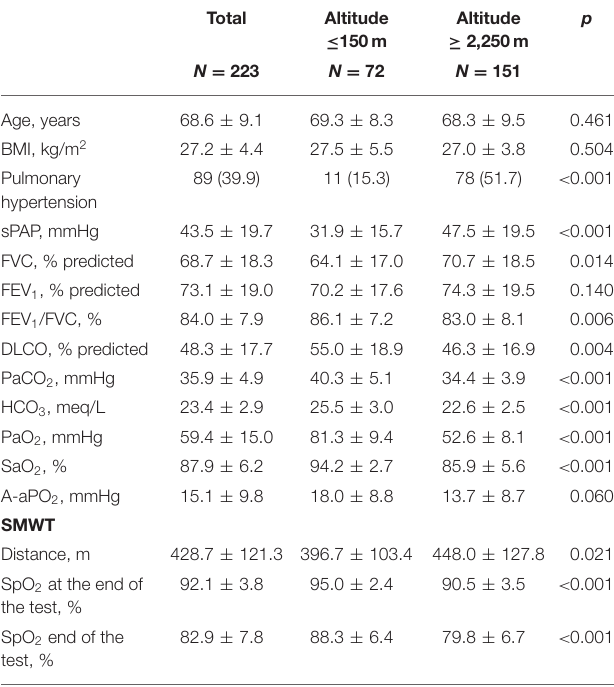
TABLE 3 | Characteristics of participants with echocardiogram by